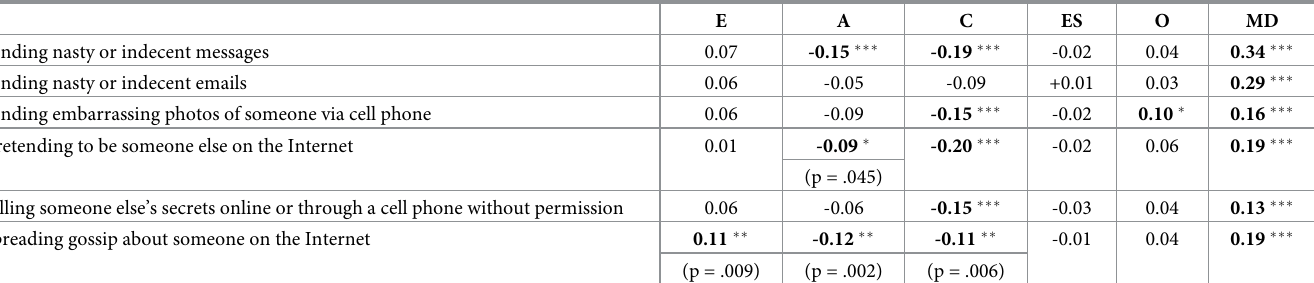
Table 4. Product-moment correlations between personality factors, aggressive behaviours, and moral